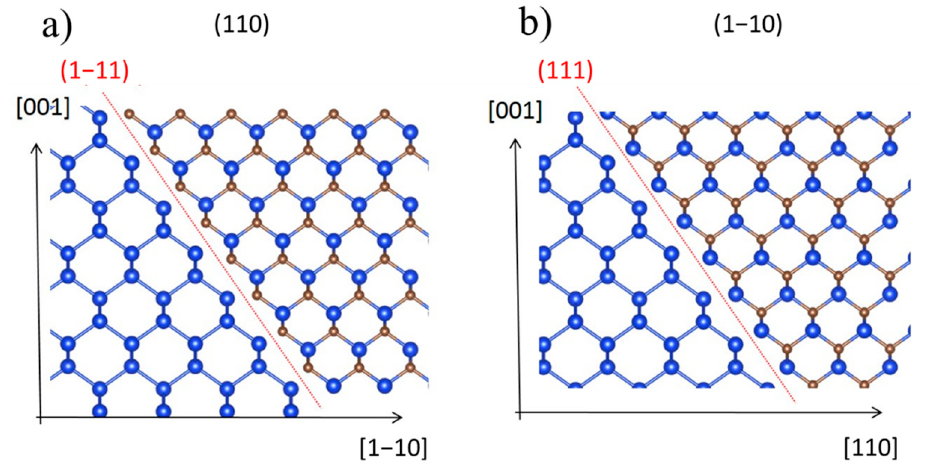
Figure 3. Projections of Si / SiC bi-crystal interface on (110) ( a ) and (1 − 10) ( b ) planes. The Red line represents the {111} plane and the interface between Si and SiC crystals.